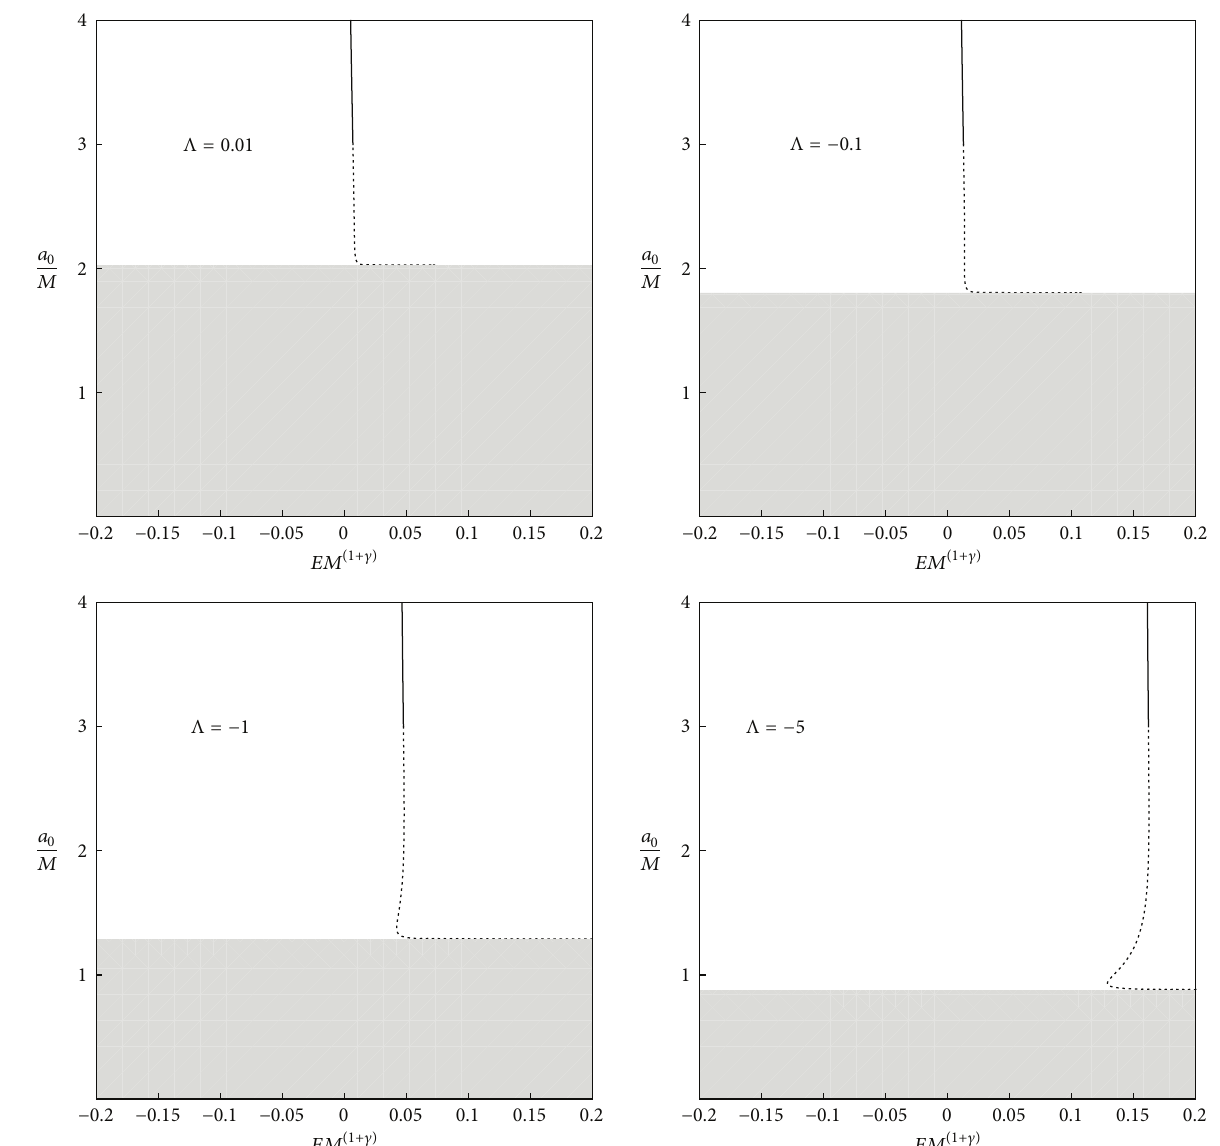
Figure 8: Plots corresponding to MCCG with 𝛾 = 0.6 , 𝑀 = 1 , 𝐴 = 2 , and 𝑤 = −10